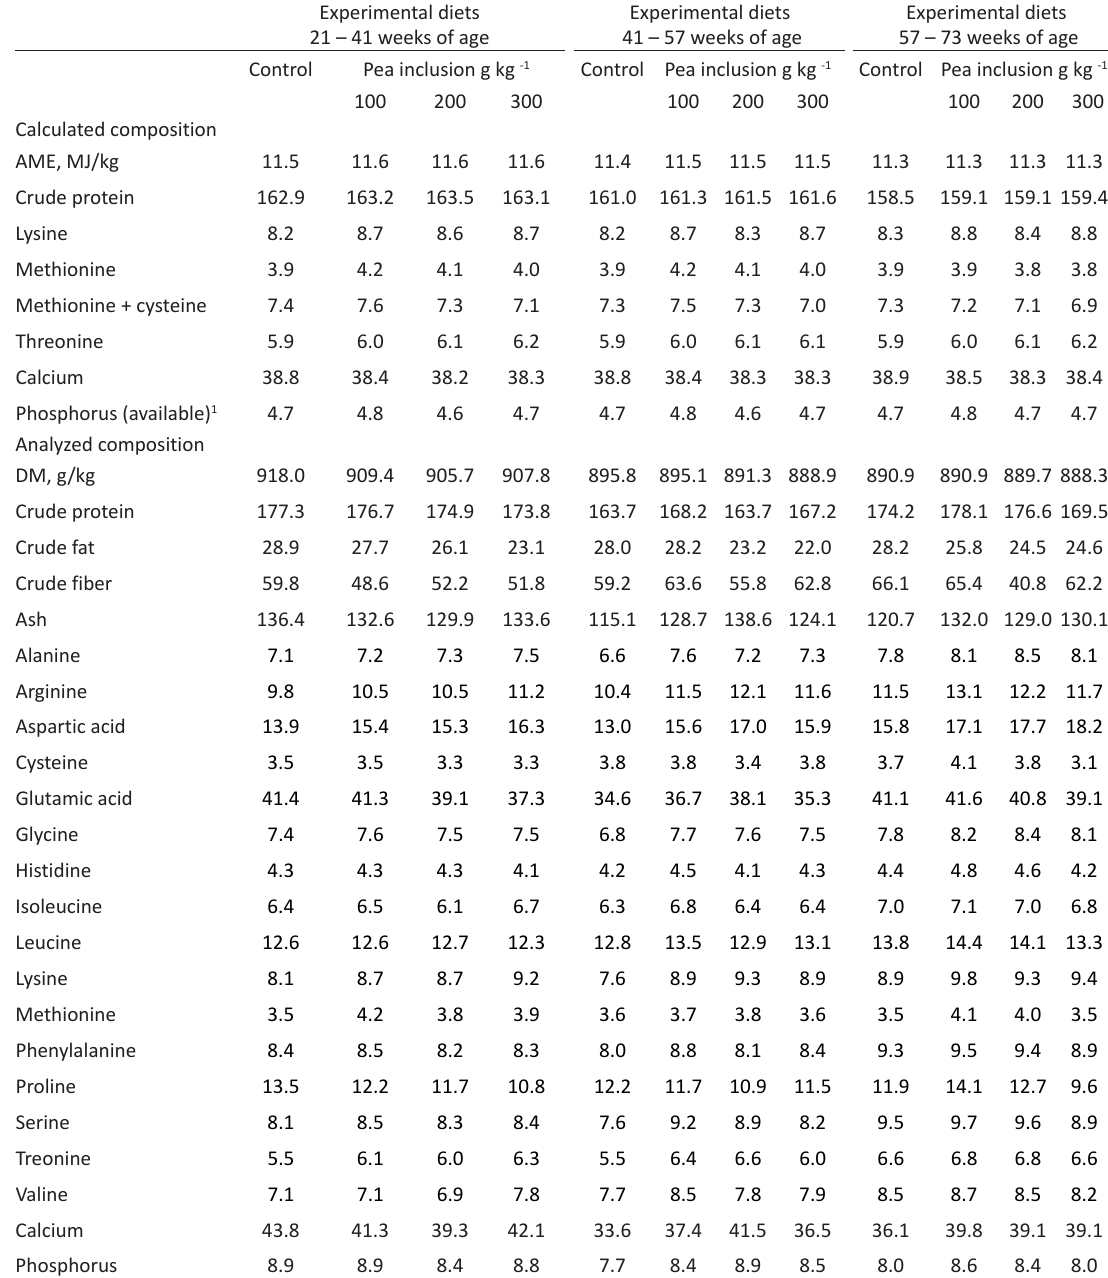
Table 2. Calculated and analyzed chemical composition of the experimental diets (g kg -1 DM), except AME and